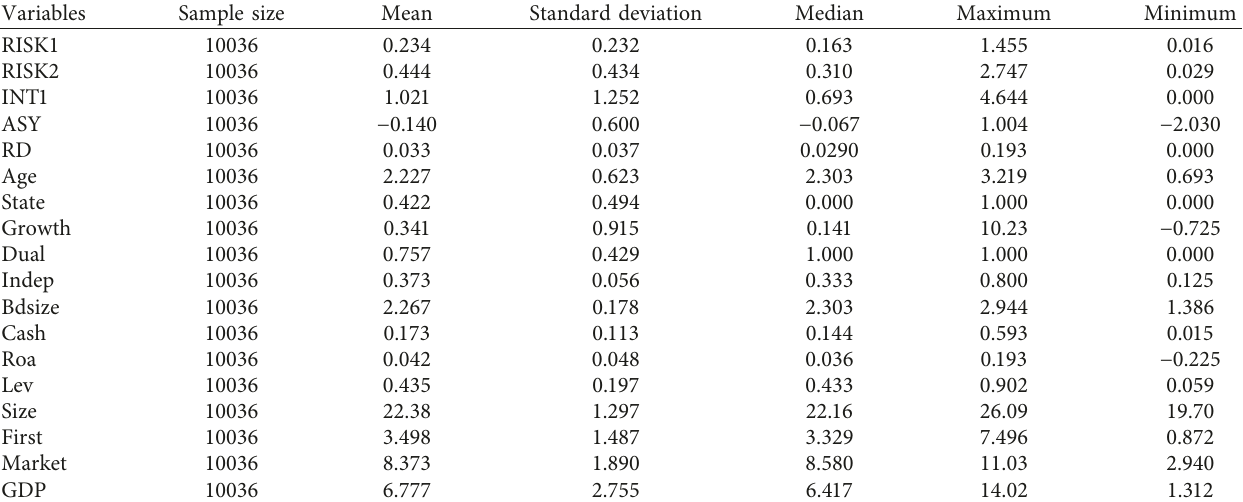
Table 1: Descriptive statistics of variables.